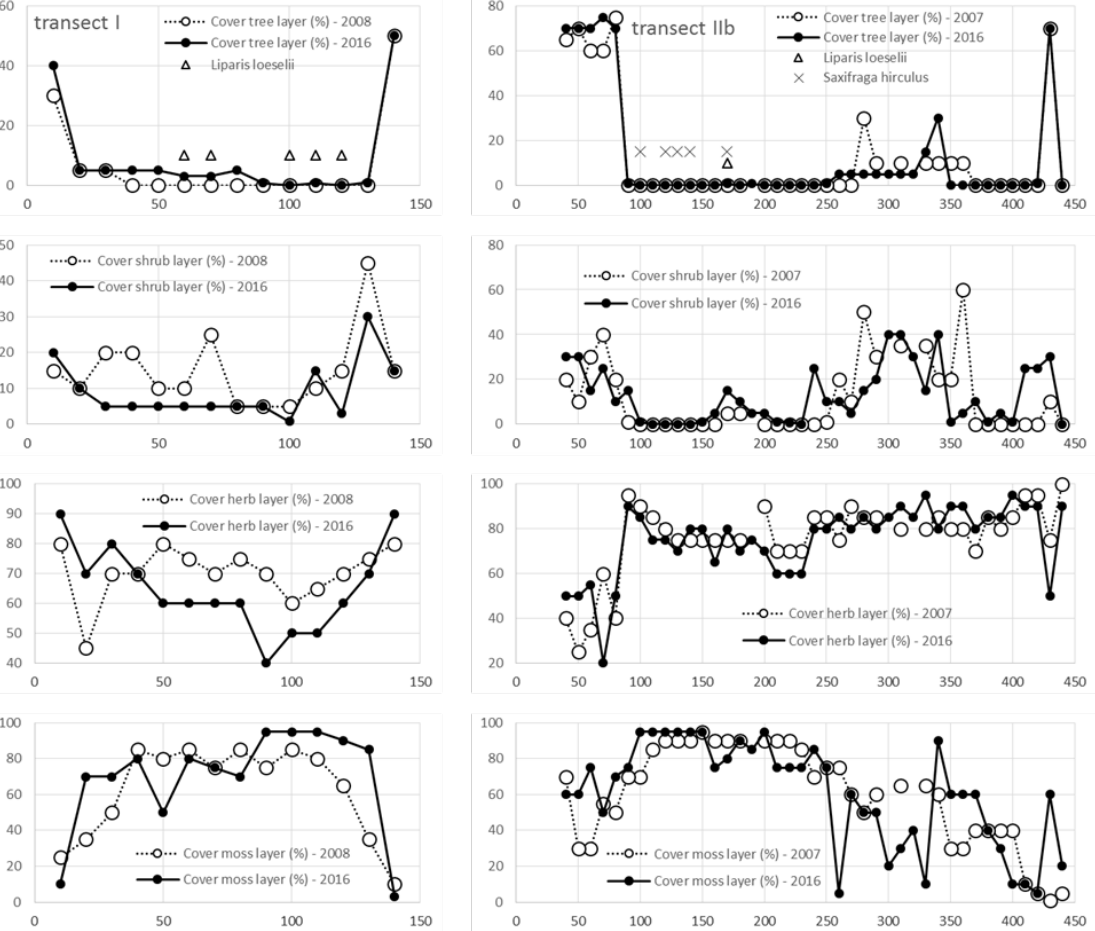
Figure 3. Cover of tree, shrub, herb and moss layers along the non-forested part of Transect I (on the western side of the mineral island within the Rospuda mire) and along Transect IIb, in 2007/2008 and 2016. Relevés with Liparis loeselii and Saxifraga hirculus in 2007/2008 are marked. In Figures 3–6, all panels show variation in cover along the transect, from mire margin (left side of graph) to the Rospuda river (right side of